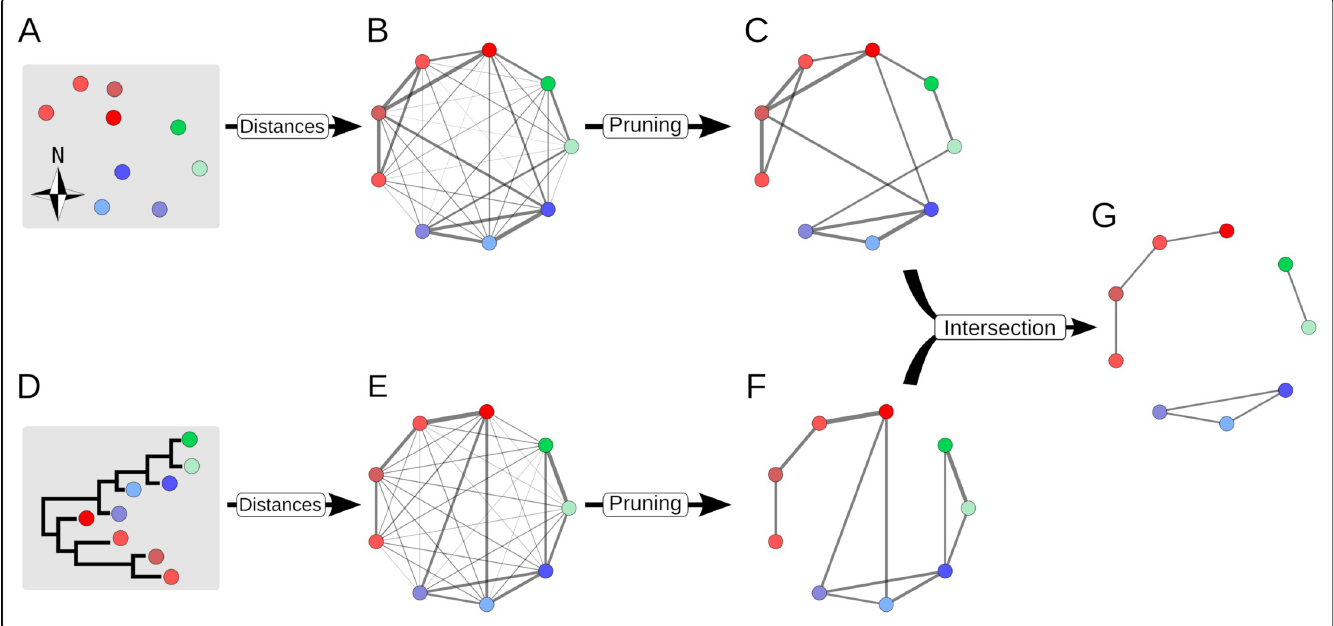
Fig 1. Schematic illustration of our graph approach for combining multiple data streams to identify outbreak clusters. In this example, two data streams are considered: the spatial locations of the cases (A) and a phylogeny of pathogens from these cases (D). The three ‘actual’ outbreak clusters are identified in red, blue and green, using different shadings to identify individual cases. Each data source defines a fully connected graph where nodes represent cases and edges are weighted by the spatial (B) and genetic distances (E). Thicker edges represent smaller weights (distances) between cases. Each graph is then pruned separately, removing edges whose weight exceeds a given cutoff (C, F). The intersection of these graphs defines a new graph which retains only edges present in every pruned graph (G). The resulting clusters of cases indicate likely outbreak clusters.